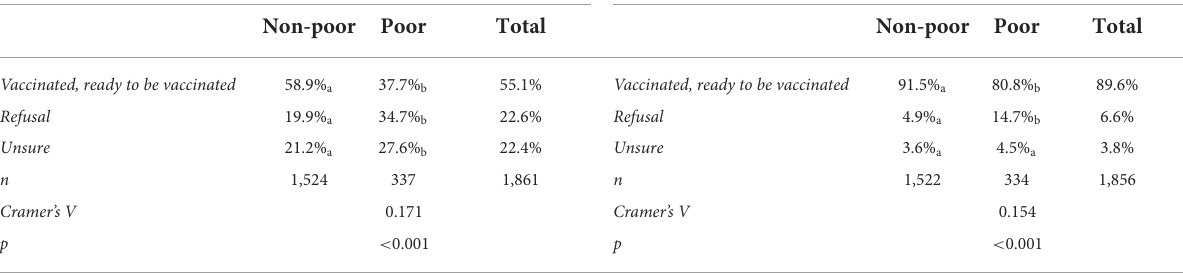
pandemic. Comparison of the two groups showed a significantly higher mean among the income poor (2.06) vs. the non- poor group (1.80). Since statistical requirements for parametric testing were not fulfilled, a Mann–Whitney- U- test was carried significant difference between poor vs. non-poor persons: U = 223,434.000, p < 0.001, r = 0.089. In addition, most participants report few symptoms of anxiety: Using the GAD-7 scoring system 85% of the sample were classed as having “no or minimal anxiety,” 13% could be classed as having “slight anxiety.” Comparing both groups, a small effect ( Cramer’s V = 0.086, p < 0.001) can be stated: significant more older people above the poverty line reported “no or minimal anxiety” (86 vs.